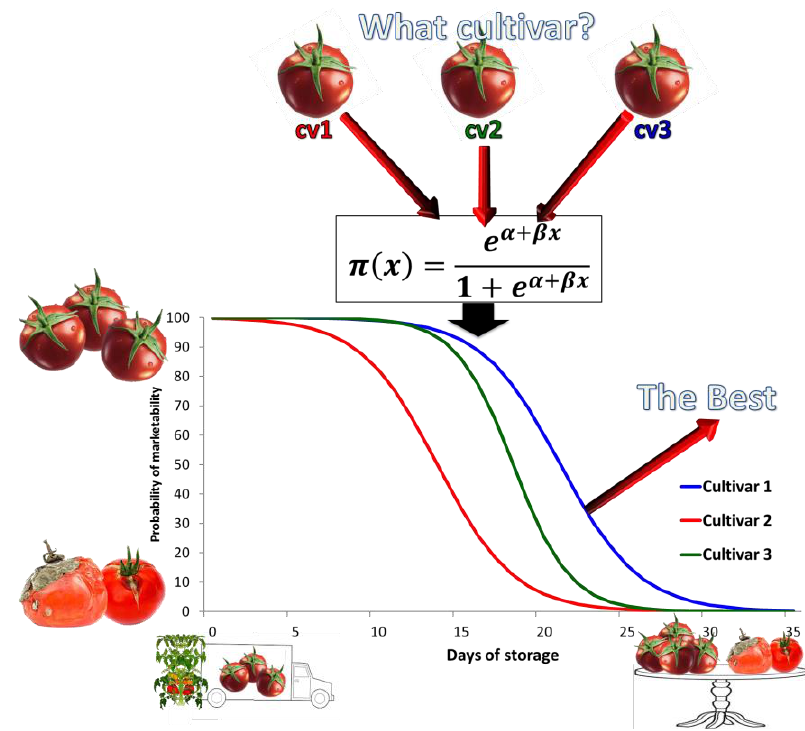
Figure 1. Diagram of the interest in and practical application of the logistic regression model in comparative studies of tomato cultivars to identify the cultivars with the longest postharvest commercial lives. Where π (x) is the probability that a tomato fruit is marketable, “x” are the days of storage, “e” is Euler's number, “α” is the intersection, and “β” is the slope parameter.